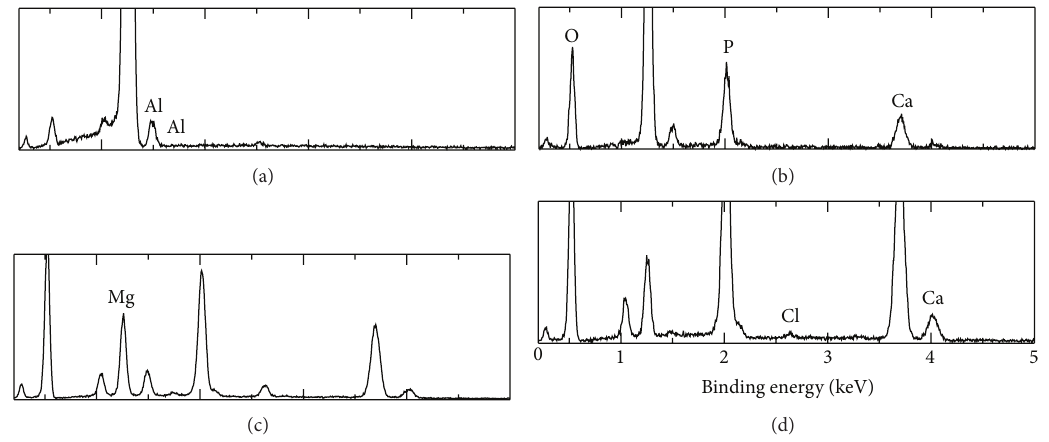
Figure 7: EDS patterns of coatings obtained at − 1.4V before and after immersion in SBF solution for 1 day and 7